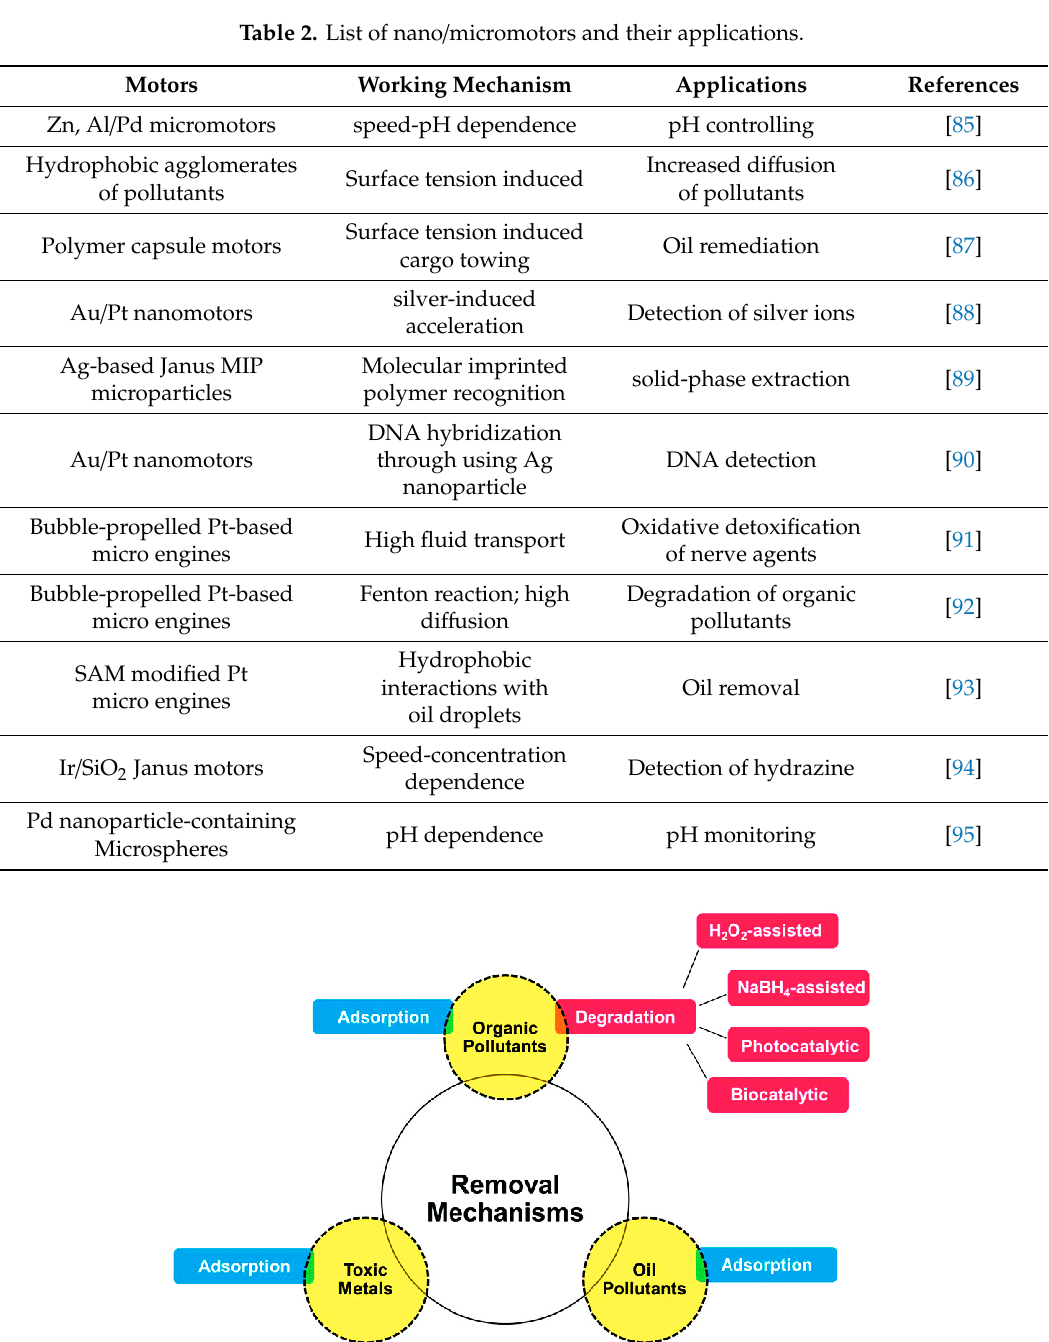
Table 2. List of nano / micromotors and their applications.